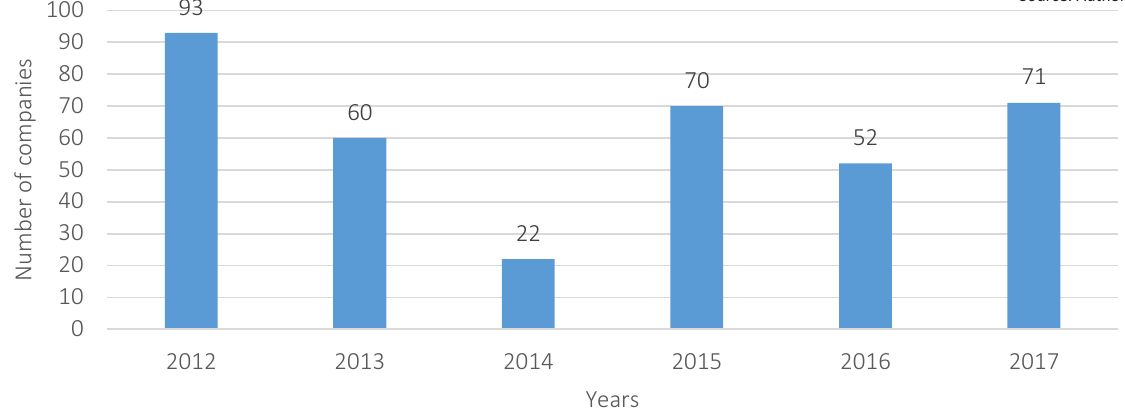
Figure 1. Number of companies with the input efficiency value of 1